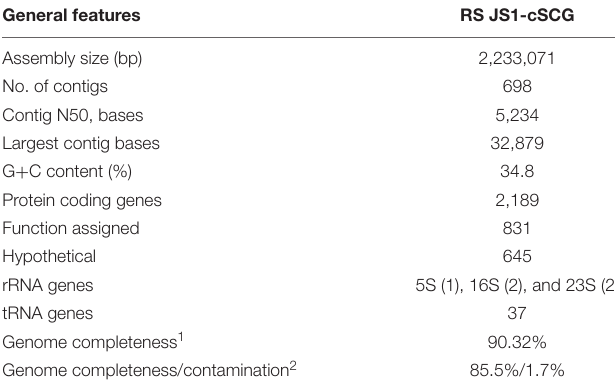
TABLE 2 | Assembly statistics and genomic features of RS